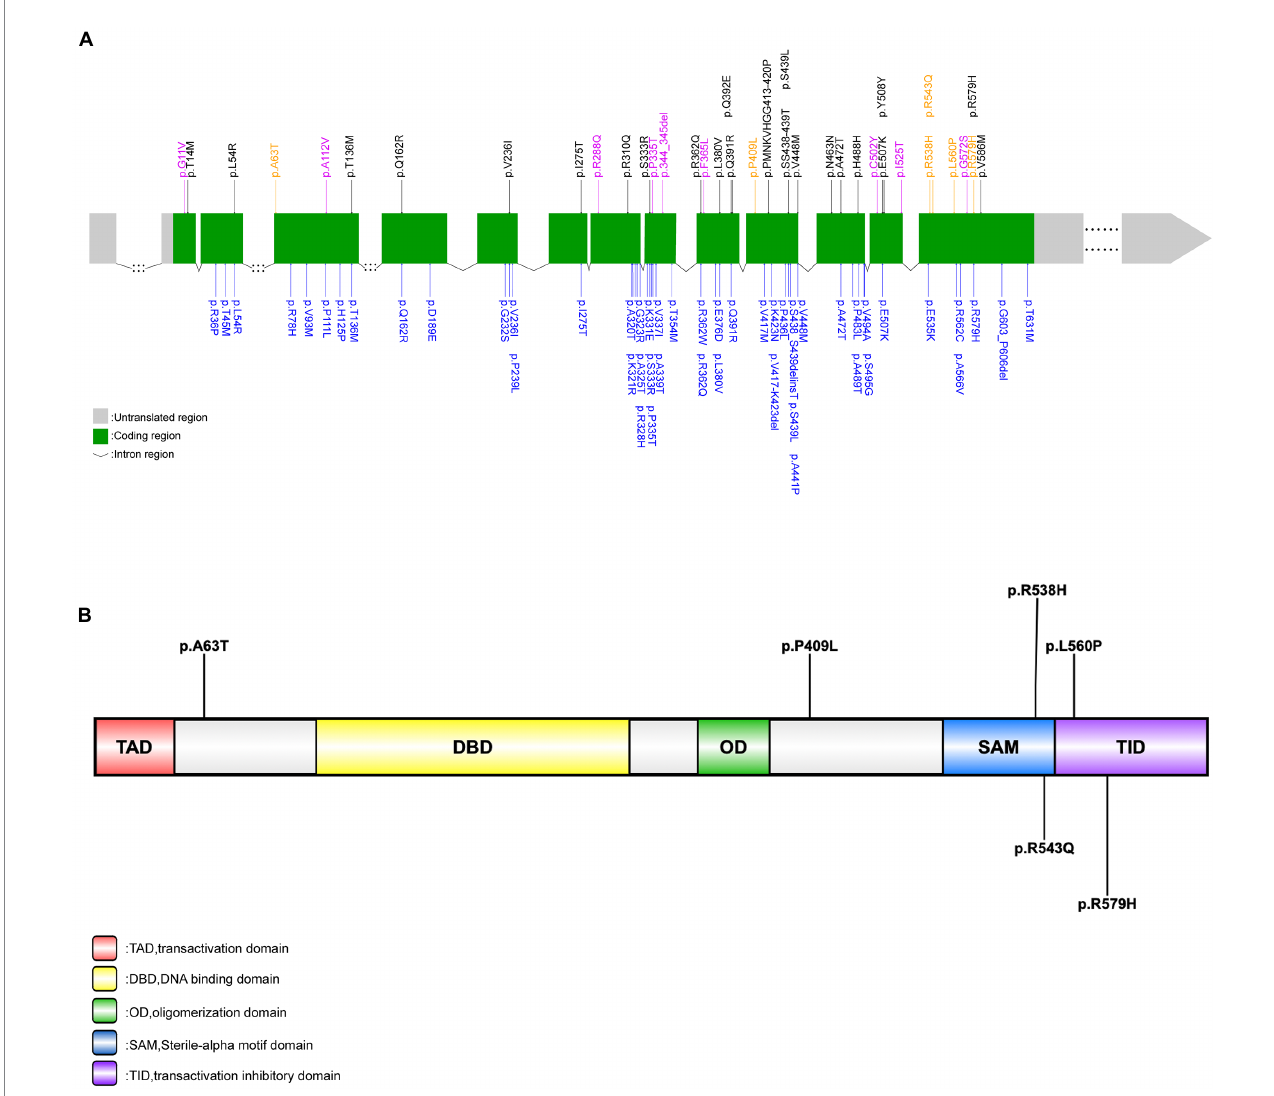
FIGURE 1 Rare TP73 variants identified in Russell et al.’s (2021), Dilliott et al.’s (2022), and this study. (A) Schematic representation of the TP73 transcript NM_005427. Rare, putative pathogenic missense variants identified in this study’s ALS cohort (yellow font); rare variants identified in this study’s control group (purple font); rare, protein-coding variants in TP73 identified by Russell et al. (2021) (black font); rare, non-synonymous variants in TP73 identified by Dilliott et al. (2022) (blue font). (B) Schematic representation of the TAp73 protein. Rare, putative pathogenic missense variants identified in this study (black